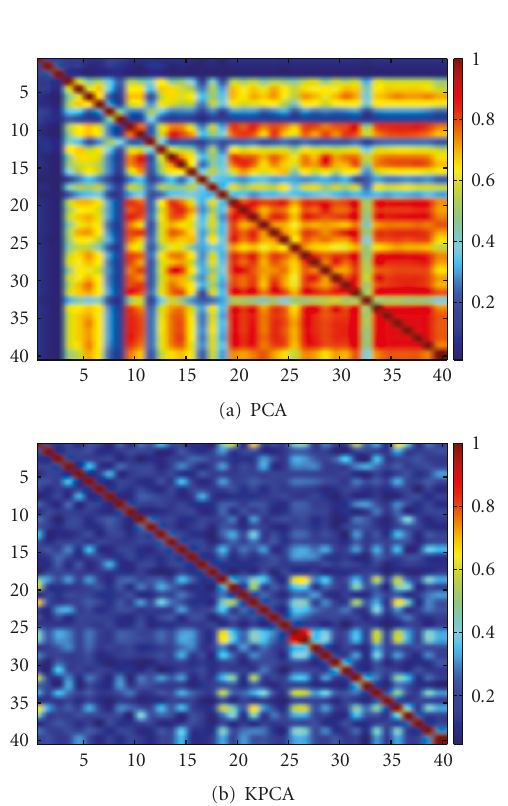
Figure 5: Mutual Information matrices for the Washington DC data